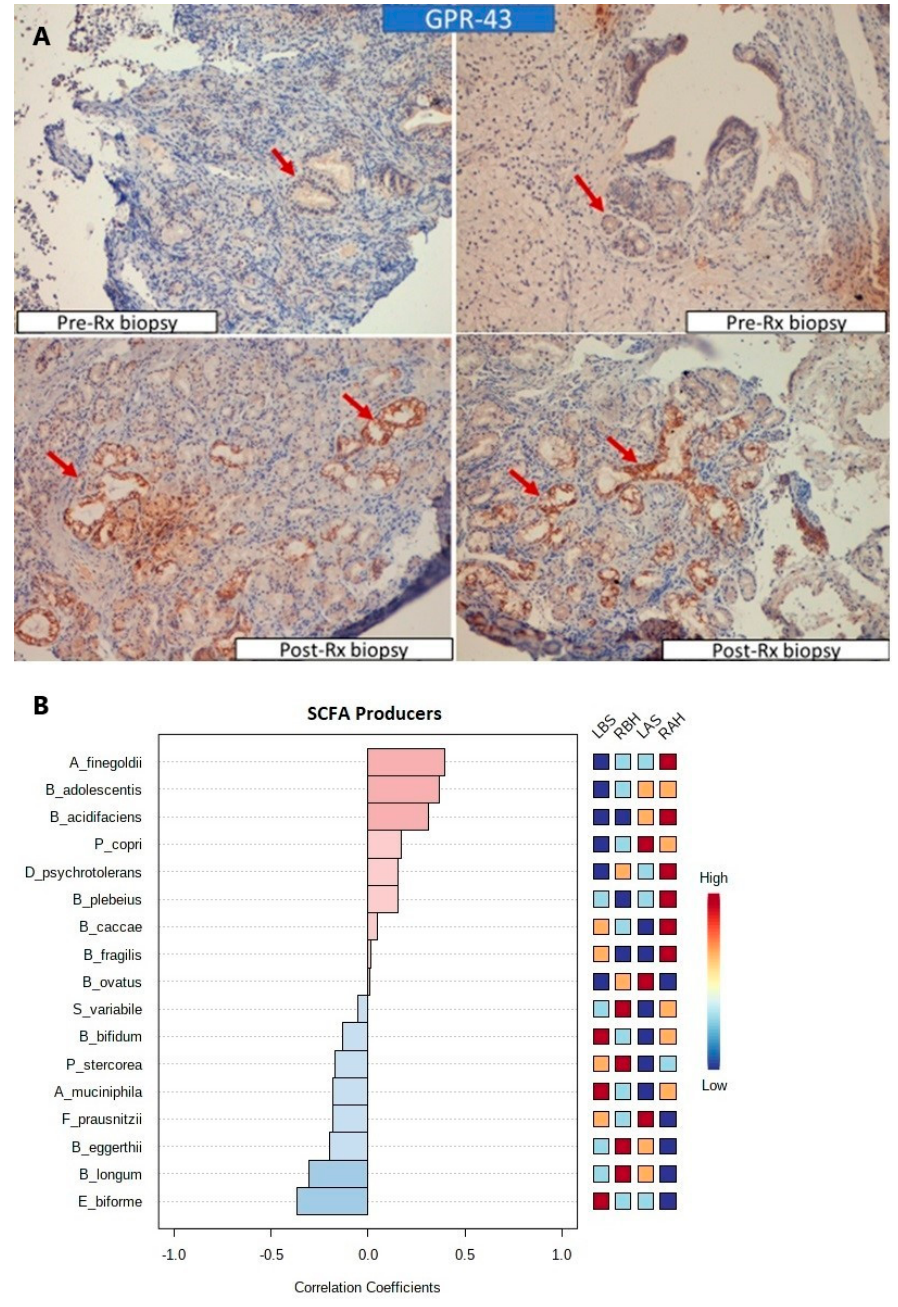
Figure 7. GPR43 overexpression with honey treatment in AtR patients: ( A ) immunohistochemistry pictures showed increased GPR43 receptors in the post-honey-therapy biopsy specimens. ( B ) A mini-heatmap of SCFA producers pattern. Correlation coefficients indicate positive or negative correlations, and colors indicate high (red) or low (blue) relative abundances of the OTUs in the corresponding study groups.